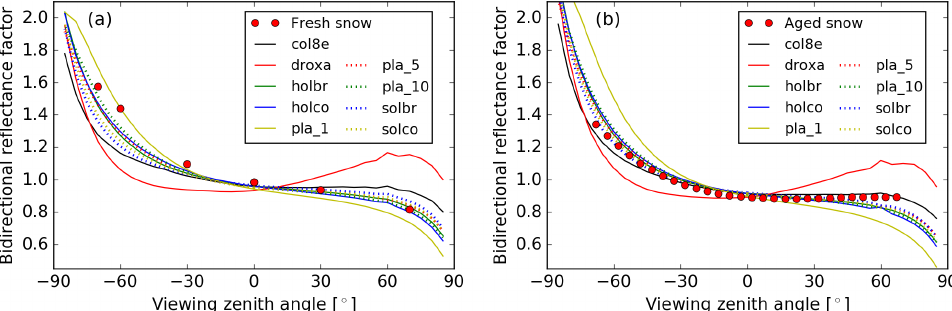
Figure 4. The comparison of angle dependence of laboratory-measured and simulated snow reflectance: (a) fresh snow sample and (b) aged snow sample. Symbols are measurements and lines are simulations with SCIATRAN, assuming different SPSs (see